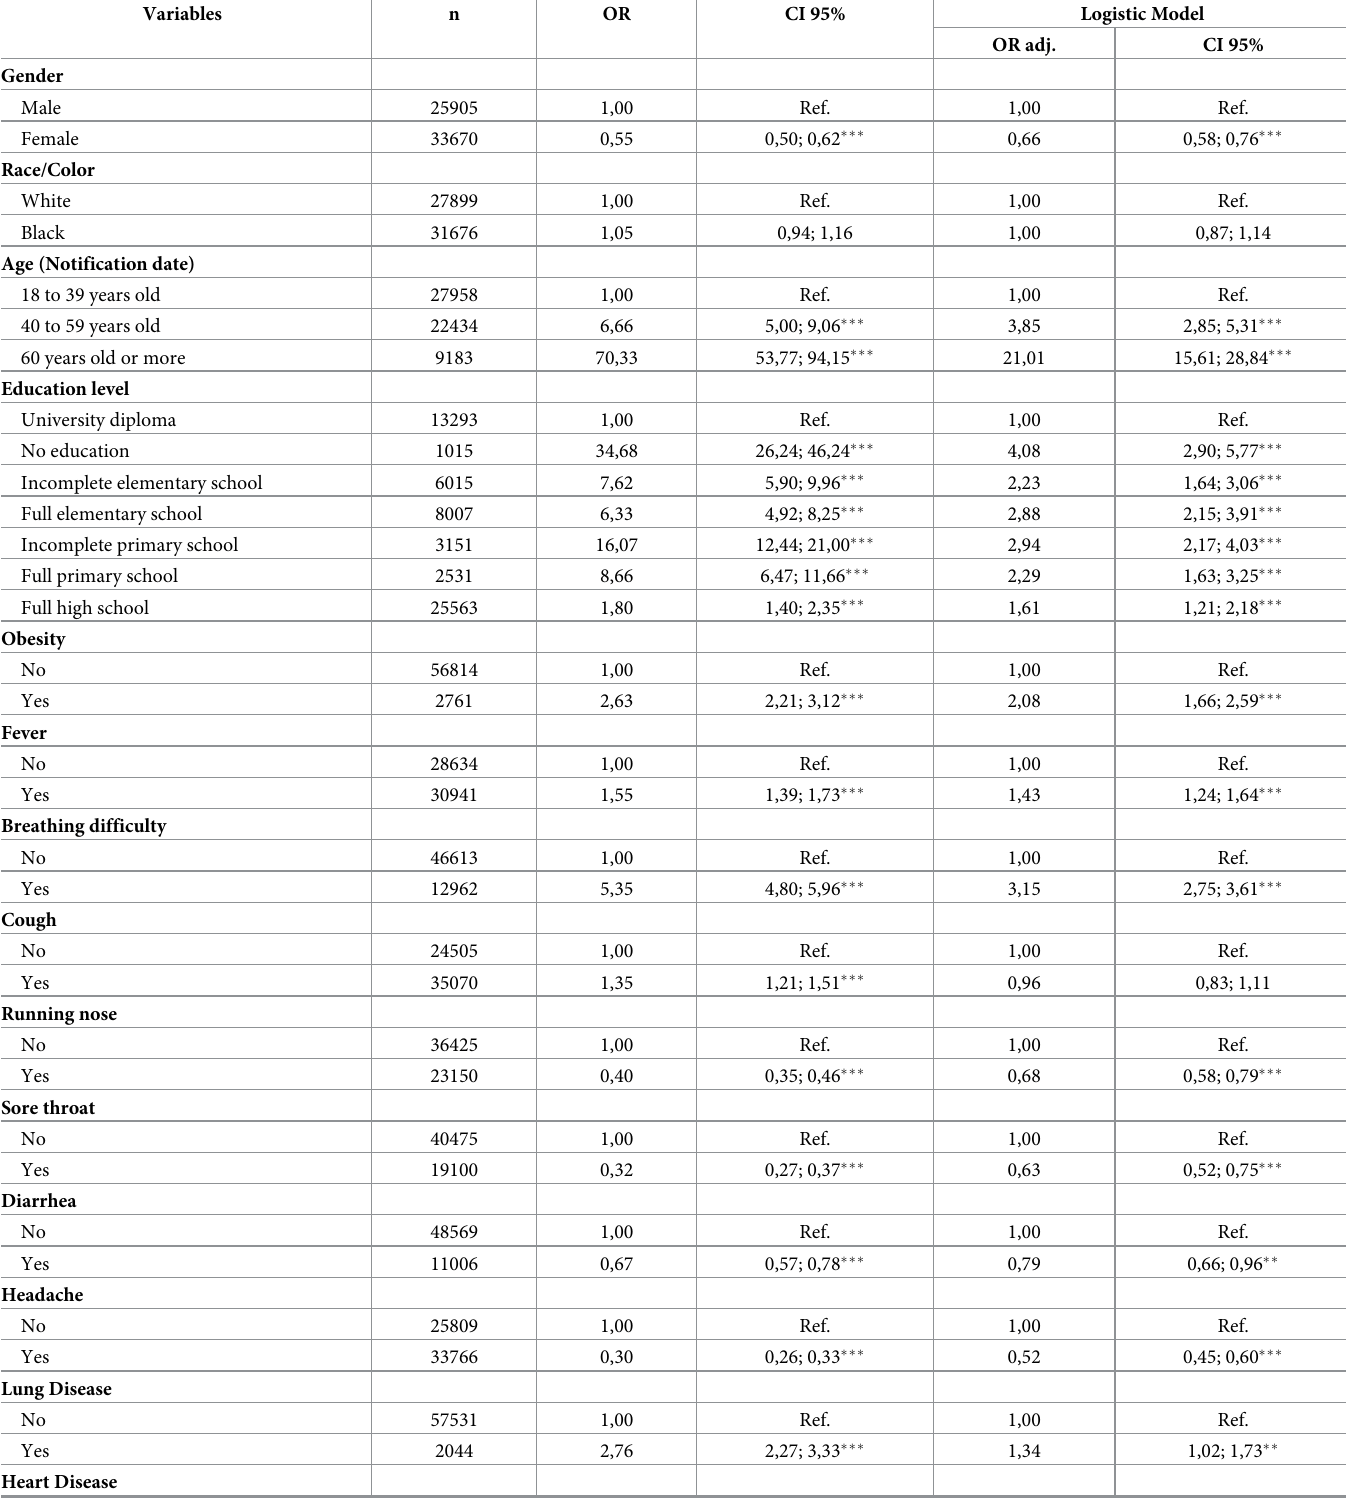
Table 5. Logistic regression model for the association of sociodemographic factors and symptoms with death by COVID-19, Espı´rito Santo, Brazil,